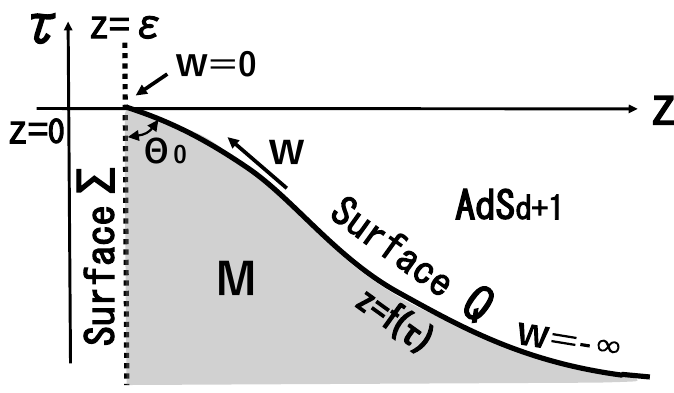
Figure 1 . The on-shell action in the shaded region M computes the Hartle-Hawking wave function, related to the path-integral optimization for holographic